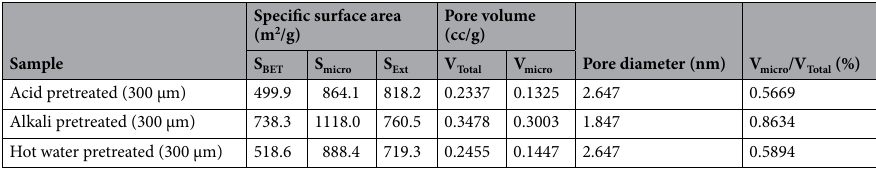
Table 11. Pore characteristics of cassava plus yam peels biomass.